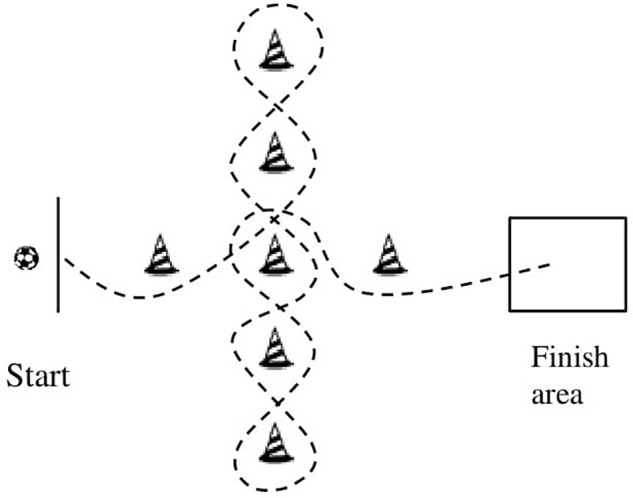
Short dribbling test (Bangsbo and Mohr, 2013).